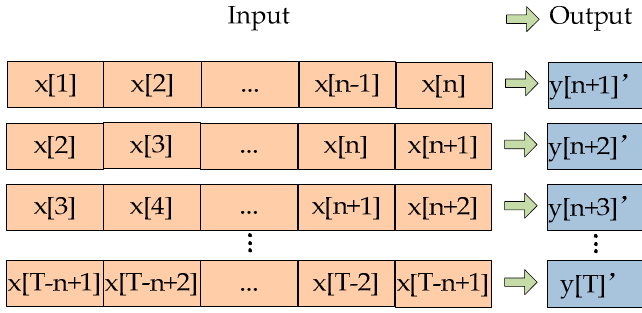
Figure 6. Schematic diagram of a sliding-window process.